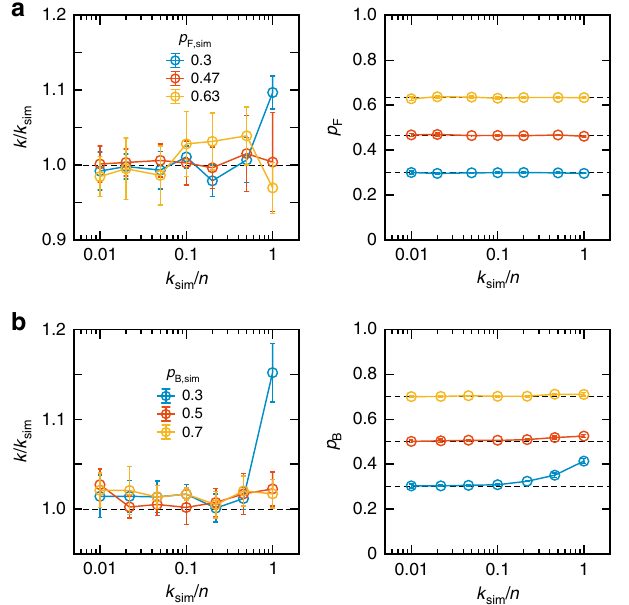
Fig. 6 Determination of the relaxation rate and population for recolored photon trajectories. See Supplementary Fig. 10 for the acceptor fractions. a α 3 D folding. Experimental photon trajectories collected at three different GdmCl concentrations (blue, 2 M, p F = 0.3; red, 2.25 M, p F = 0.47; yellow, 2.5 M, p F = 0.63) were recolored using the corresponding maximum likelihood parameters except the relaxation rate ( k F + k U , k sim ) that was varied in the simulation. b TAD/NCBD binding. Experimental photon trajectories at 0 mM NaCl were recolored using the extracted maximum likelihood parameters at 0 mM NaCl except the relaxation rate ( k B + k U , k p sim ) and bound fraction ( B,sim , blue, 0.3; red, 0.5; yellow, 0.7) that were varied in the simulation. n is the average photon count rate of the three- color segments, which are ~80 ms − 1 for α 3 D folding and 65 ms -1 for TAD/ NCBD binding. Horizontal dashed lines in p F and p B indicate the values in simulation. Error bars are standard deviations of the parameters obtained from fi ve recolored data set. Source data are provided as a Source Data fi